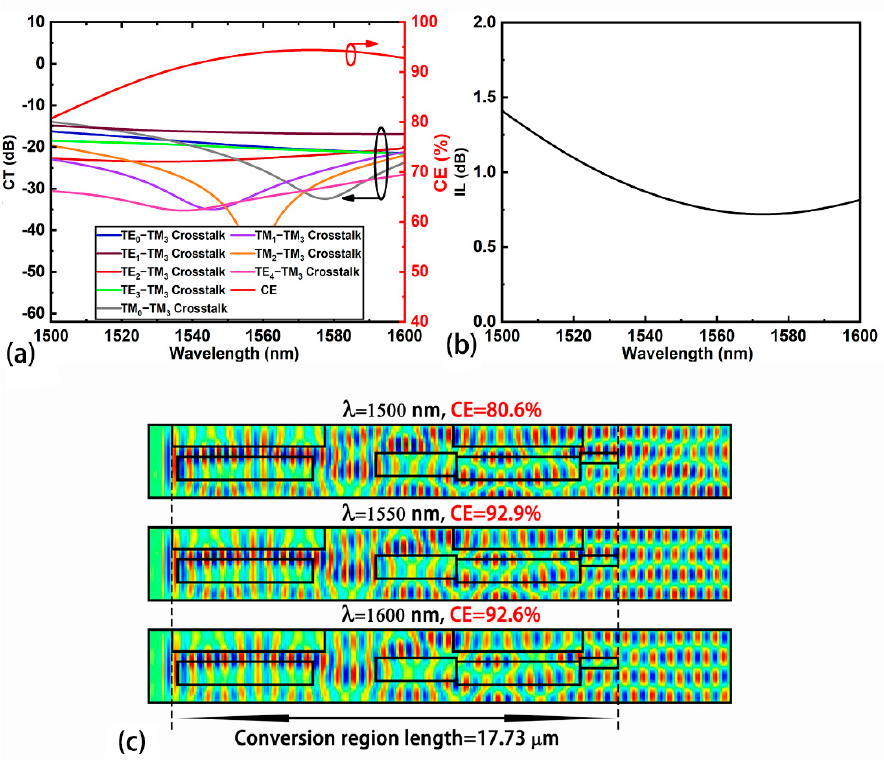
Figure 4. ( a ) Wavelength spectra of mode CE and CT of the proposed TM 0 -to-TM 3 mode-order converter ( λ = 1500~1600 nm). ( b ) Wavelength spectra of mode IL of the proposed TM 0 -to-TM 3 mode- order converter ( λ = 1500~1600 nm). ( c ) Electric field evolution through the designed device working at different wavelengths ( λ = 1500, 1550, 1600 nm). Total mode conversion length was 17.73 μ m.